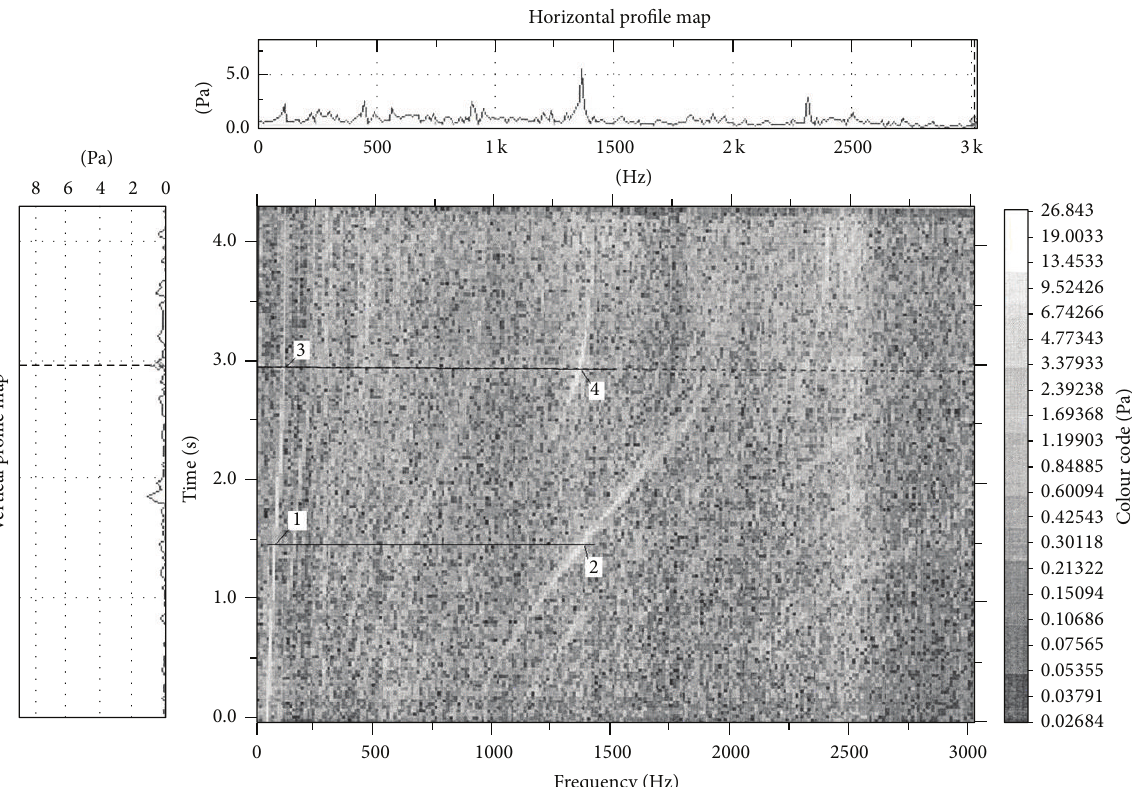
Figure 1: In the conditions of pass-by noise in the 6-speed, the three-dimensional distribution of spectral array on the near-field noise of the left